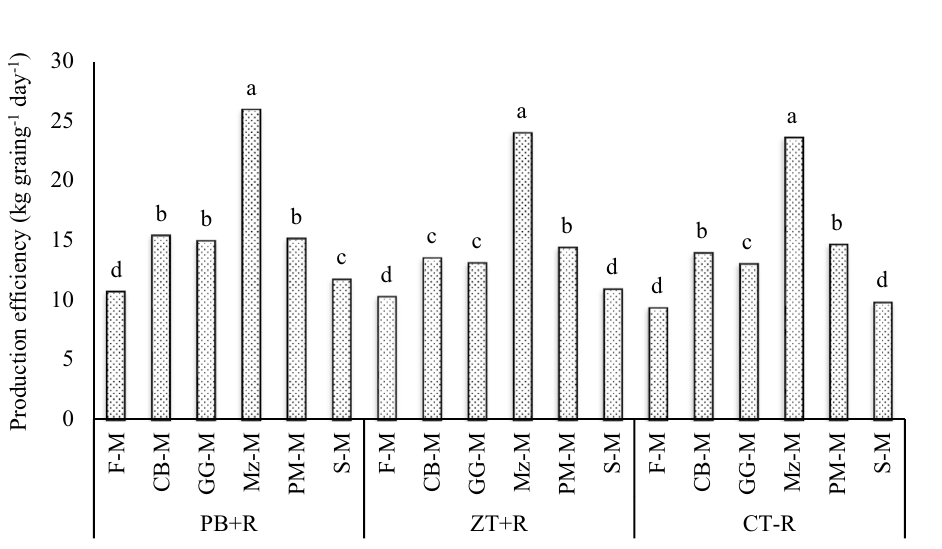
Figure 4. Production efficiency of CA-based Indian mustard systems (3-year